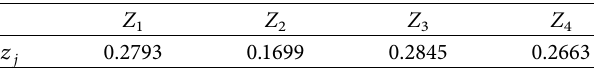
Table 8: The attribute weights r